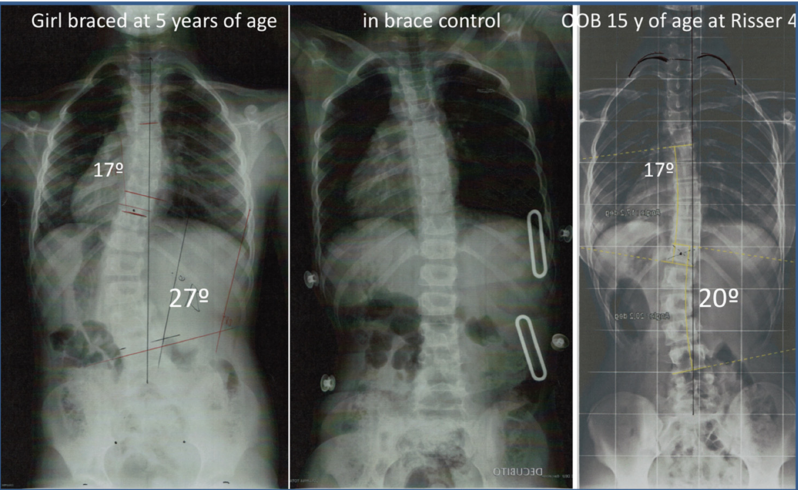
Figure 5. Example of success. Result of treatment in a girl braced at 5 years of age with a left lumbar scoliosis of 27 ◦ , completing treatment under night-time regimen until 15 years of age at Risser 4, stopping treatment with a left lumbar curvature of 20 ◦ .